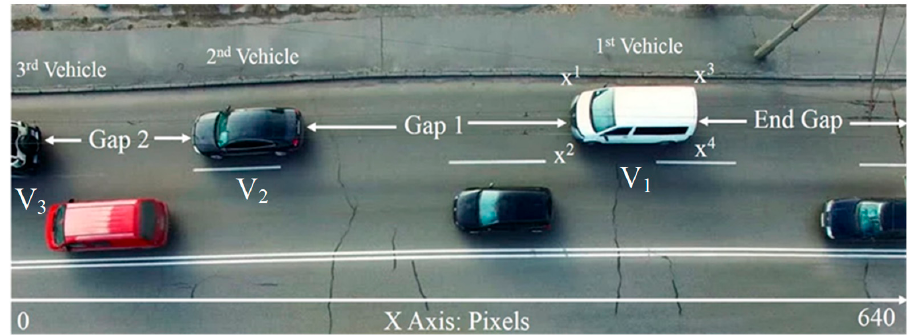
Figure 6. Illustration of calculation of parking gaps.